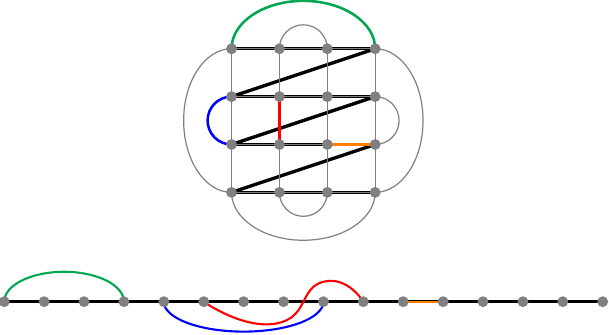
FIG. 1. An example choice of G (shown with gray edges) and # G (shown with solid black edges). We also highlight several edges of G to demonstrate the map between G -neighbors and paths over # G . After embedding G in the plane, we overlay a linear graph corresponding to the # G ordering. Following this, we can smoothly map any desired lattice edge to a braid sequence on the